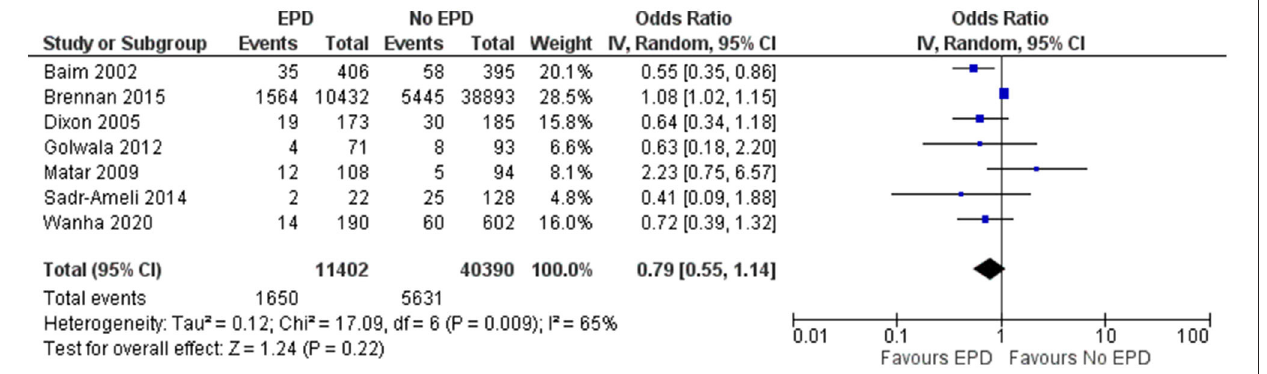
FIGURE 5 | Forest plot showing the difference in late MI between patients with and without EPD following PCI on SVG ( n = 7).